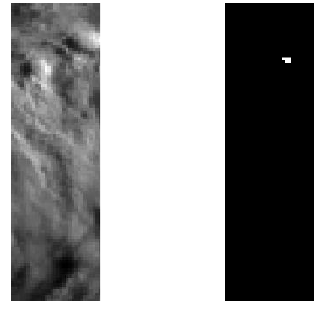
Figure9. energy spectrum of night